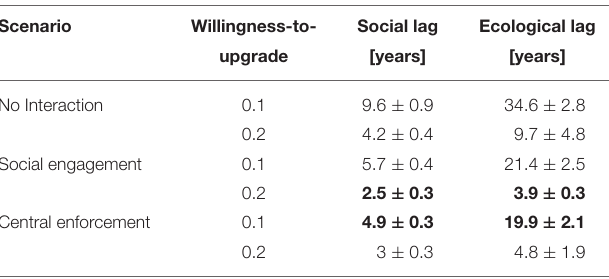
TABLE 2 | Calculated time lags from simulations under different